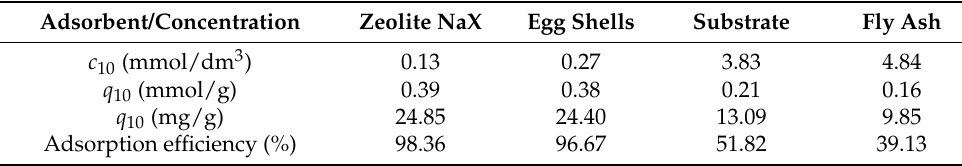
Table 1. Experimental data obtained after 10 days of adsorption